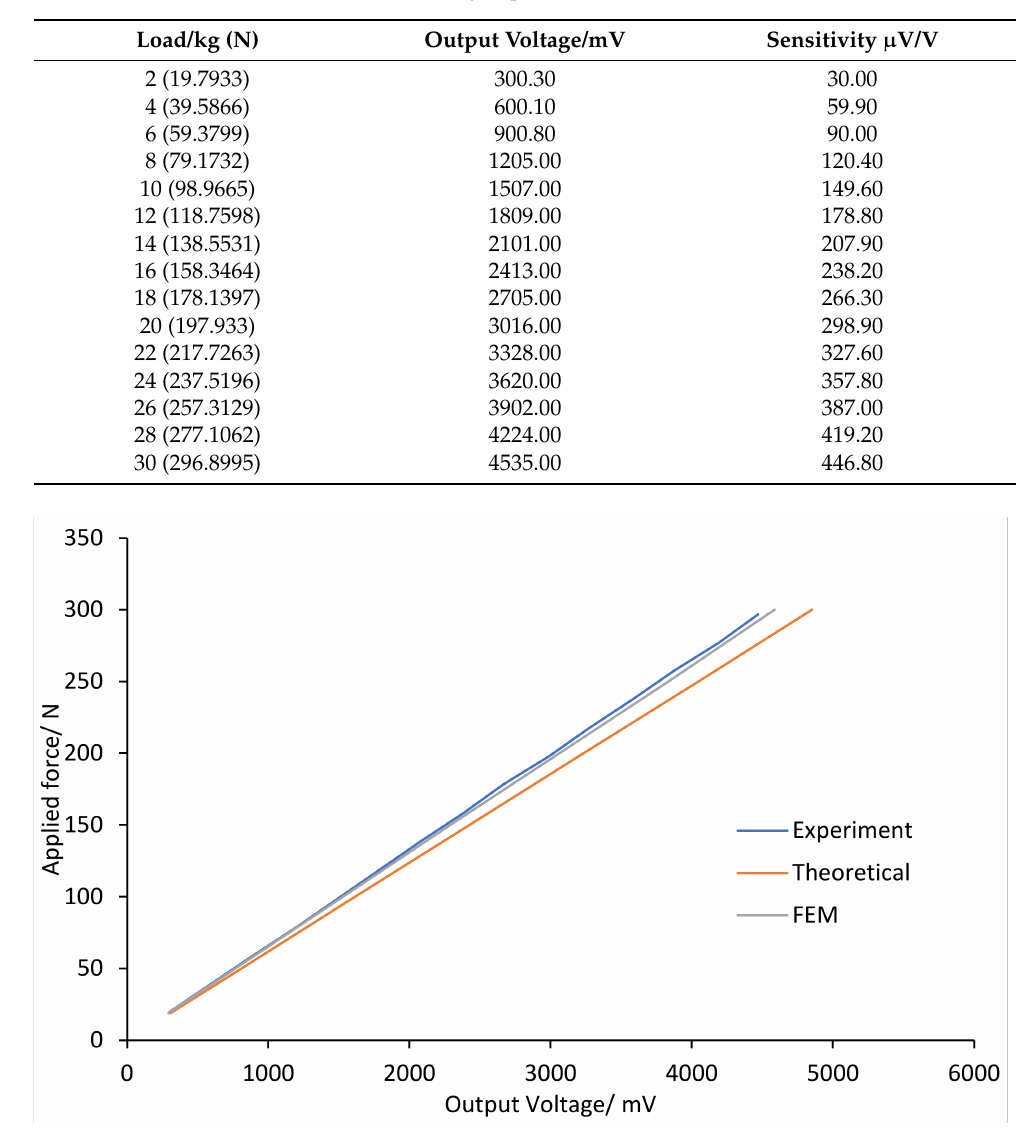
Figure 18. Output voltage versus applied load for the theoretical, FEM, and